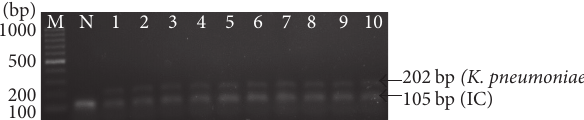
Figure4:Representativeagarosegelelectrophoresisofthermostabi- lized multiplex PCR of K. pneumoniae strains. Lane: M, 100 bp DNA ladder (Fermentas, USA); N, negative control; 1, K. pneumoniae (ATCC 1706); 2–10, clinical isolates of K. pneumoniae. Figure 5: Representative agarose gel electrophoresis of thermosta- bilized multiplex PCR of H. influenzae strains. Lane: M, 100 bp DNA ladder (Fermentas, USA); N: negative control, 1: H. influenzae (ATCC 49247); 2–10, clinical isolate of H. influenzae.